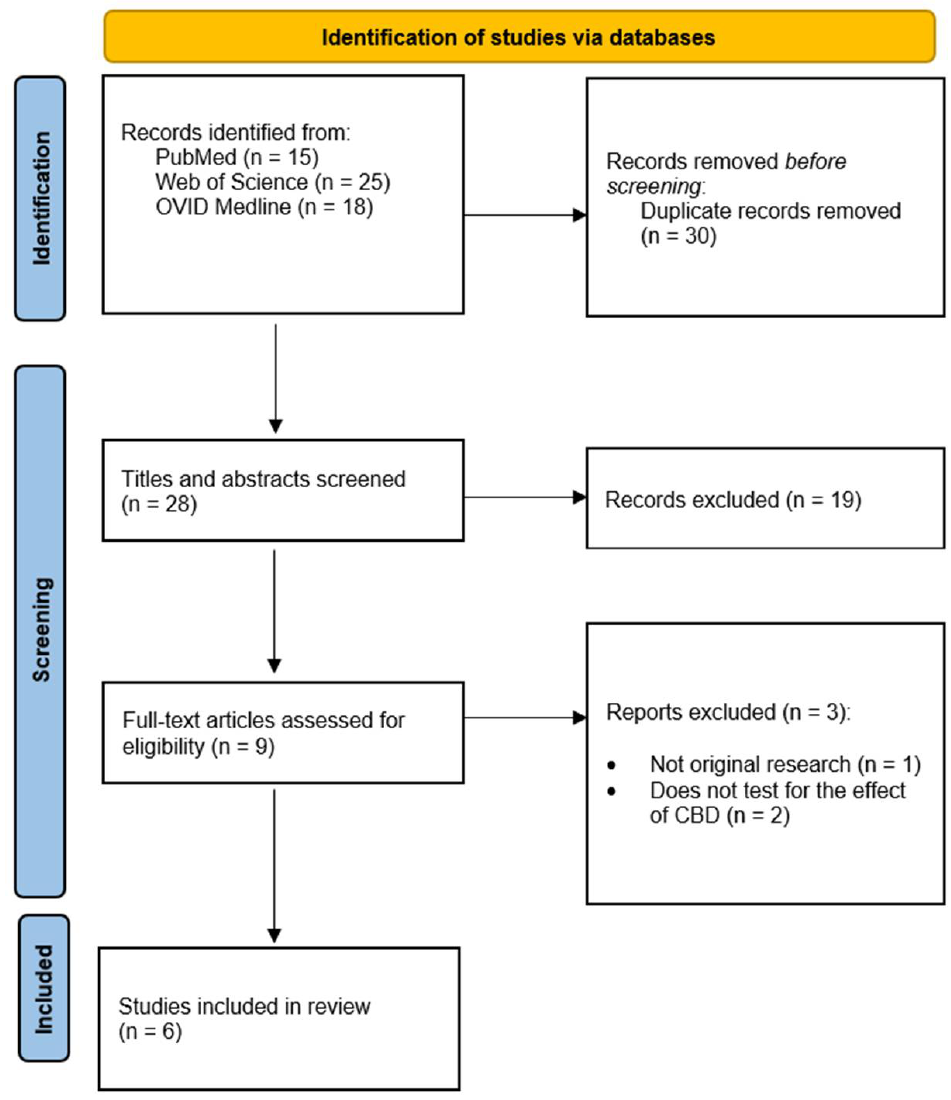
Figure 2. Process of screening articles based on the PRISMA 2020 flow diagram [34].